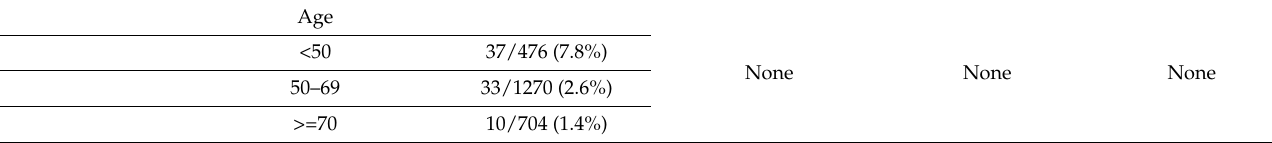
Population: All persons diagnosed with COVID-19 and current TB reported to the National Department of Health as having died from